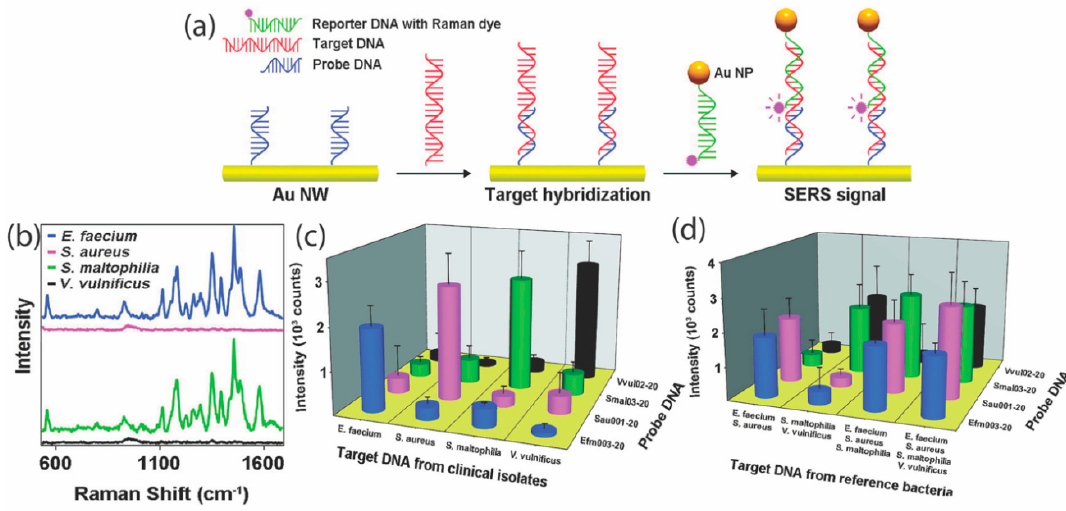
Figure 1. ( a ) An indirect surface-enhanced Raman spectroscopy (SERS)-based method for PCR-amplified pathogenic DNA detection. This method utilizes a sandwich hybridization event between a capture DNA sequence on gold nanowires and Raman reporter-labeled DNA sequence on with a target pathogenic DNA. ( b ) SERS spectra from each of the four nanowire systems in the presence of only the target DNAs of Enterococcus faecium and Stenotrophomonas maltophilia . SERS spectra of the Raman reporter (Cy5) detected only for E. faecium and S. maltophilia sensors. ( c ) SERS-based identification of amplified pathogenic DNA in clinical samples. ( d ) SERS-based multiplexed detection when all four target DNAs are present at 10 − 8 M each. Reproduced with permission from Reference [66] American Chemical Society (2010).